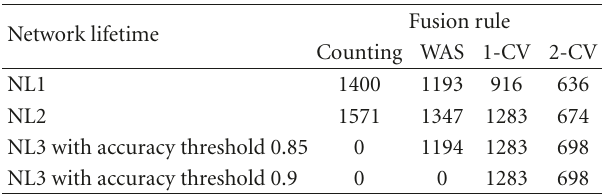
Table 1: Network lifetime in the number of sessions for various aggregation